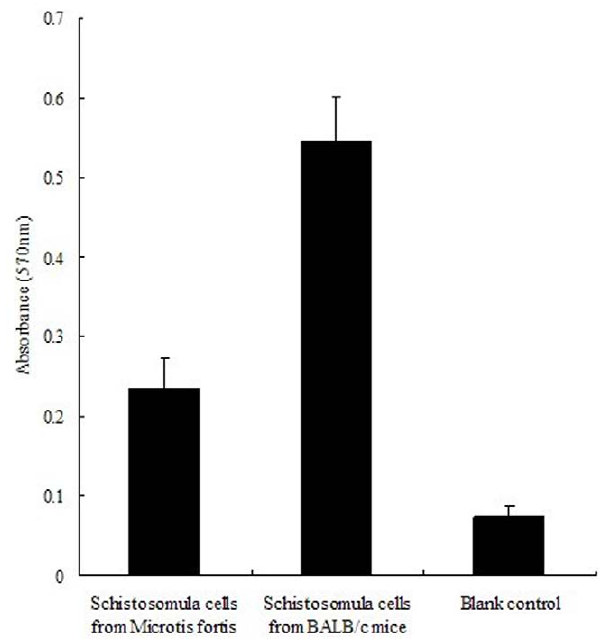
Figure 7. Proliferation of schistosomula cells obtained with schistosomula taken from BALB/c mice and Microtusfortis using the MTT assay. Cultures containing no cells comprised the blank